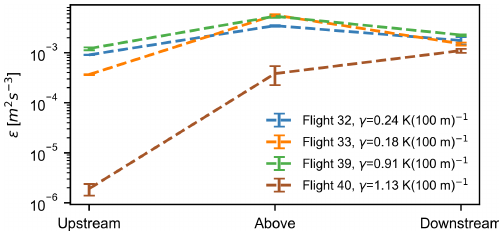
Figure 8. The rate of energy dissipation (cid:15) recorded upstream, above, and downstream of the wind farms in near-neutral and strongly stable conditions. Error bars represent the standard error of mean